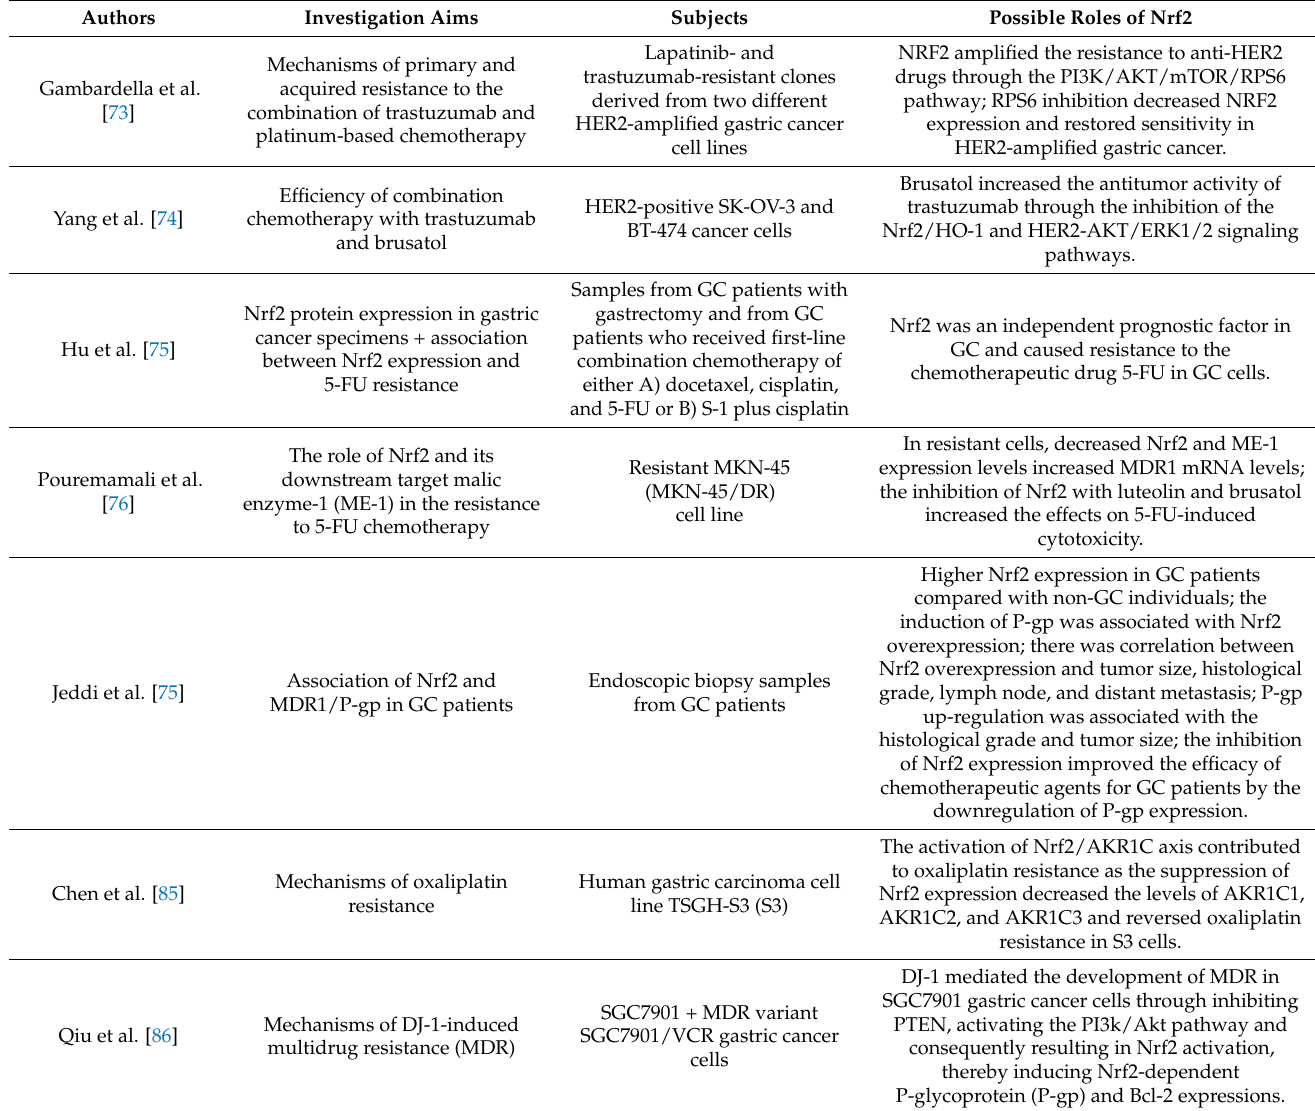
Table 1. Modulation of gastric cancer through the Nrf2